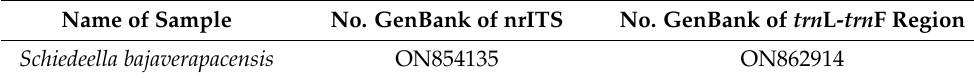
Table 4. The accession numbers of GenBank for the sample of Schiedeella bajaverapacensis